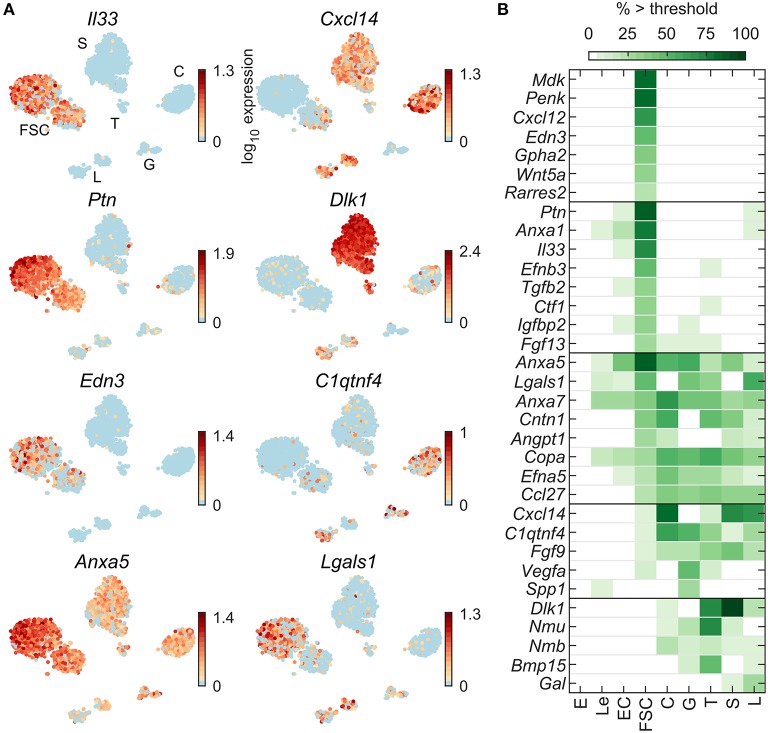
Expression of endogenous ligand genes. (A) tSNE map showing expression of select genes from the following families: cytokines (Il33), chemokines (Cxcl14), neuronal ligands (Ptn, Dlk1), ligands for G-protein coupled receptors (Edn3, C1qtnf4), and ligands that use other signaling pathways (Anxa5, Lgals1). (B) Percentage of cells per type expressing select genes above threshold. From the list of HGNC endogenous ligands gene family members, 94 were expressed in at least 5% of cells in at least one cell type (Table 2) and 44 were pituitary dominant (Table S2). The 33 most highly expressed of these are shown.